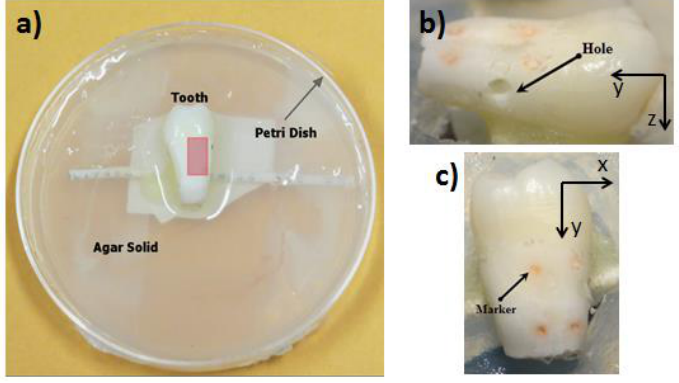
Figure 1. Phantom used in the experiment: ( a ) red shaded area on the tooth surface indicates the field-of-view (FOV, 6 mm by 4 mm). ( b ) Side view of phantom to show the hole used to hold capillary. ( c ) Markers at the corner of FOV.